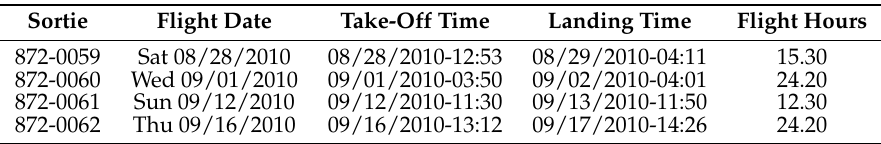
Table 1. Global Hawk flight missions for the GRIP program in 2010.